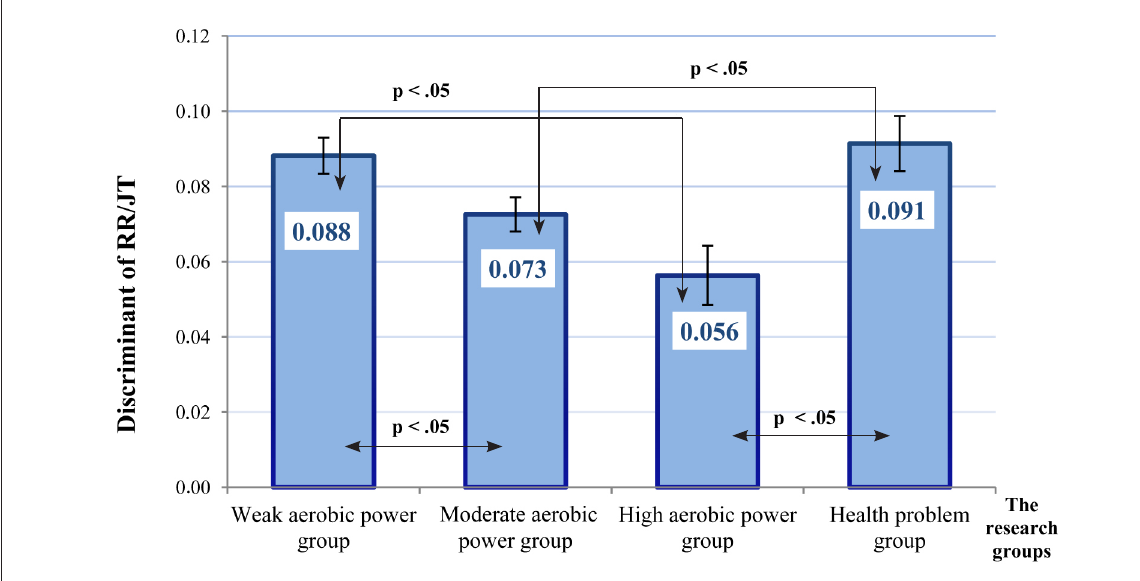
Note. p < .05 – statistical difference between groups. Figure 1. Discriminant of concatenation between RR and JT parameters at the anaerobic threshold during bicycle ergometry